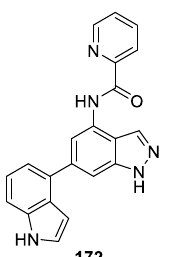
Figure 53. Chemical structure of 4,6-disubstituted-1 H -indazole derivative 172 .